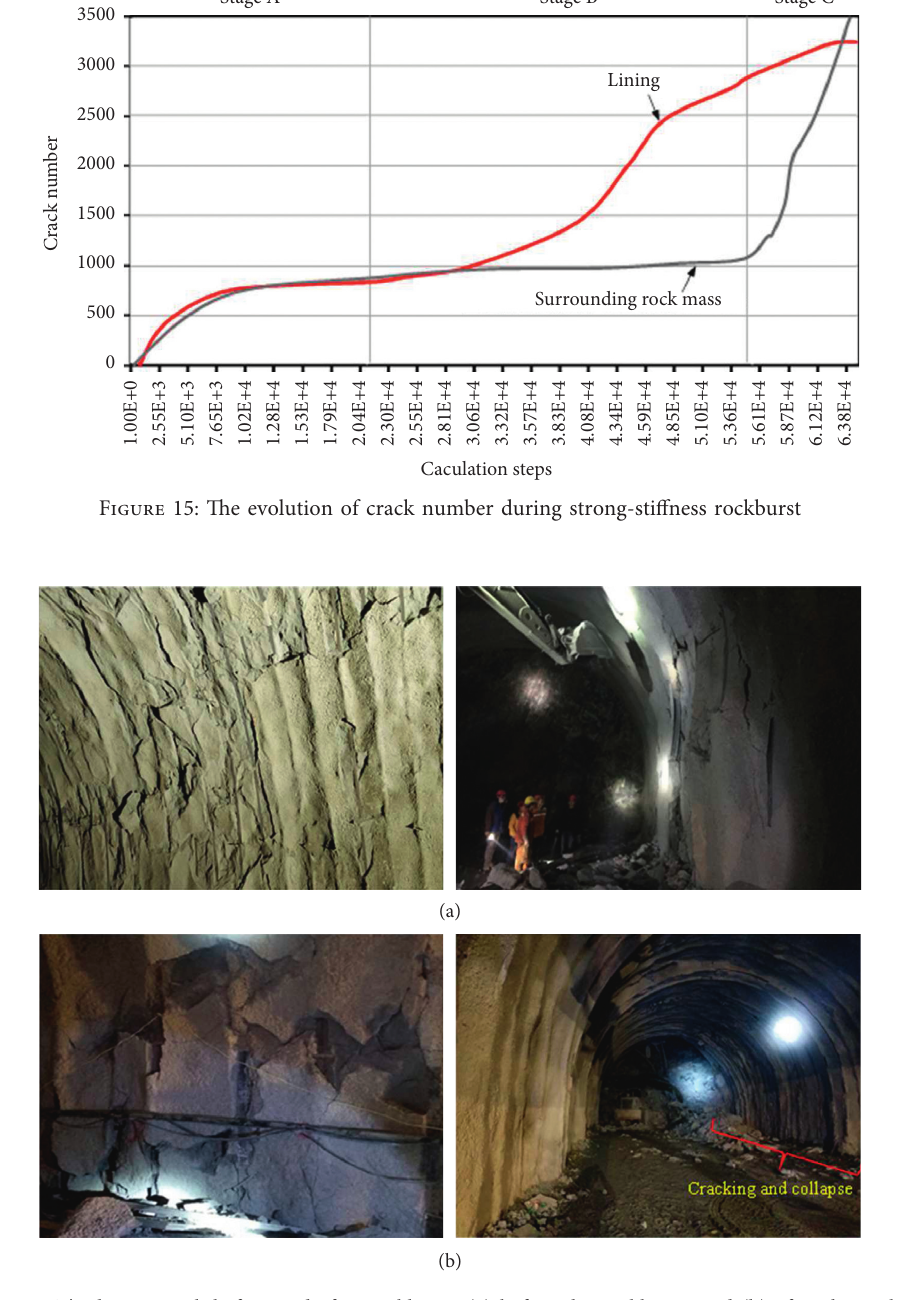
Figure 16: The lining crack before and after rockburst: (a) before the rockburst; and (b) after the